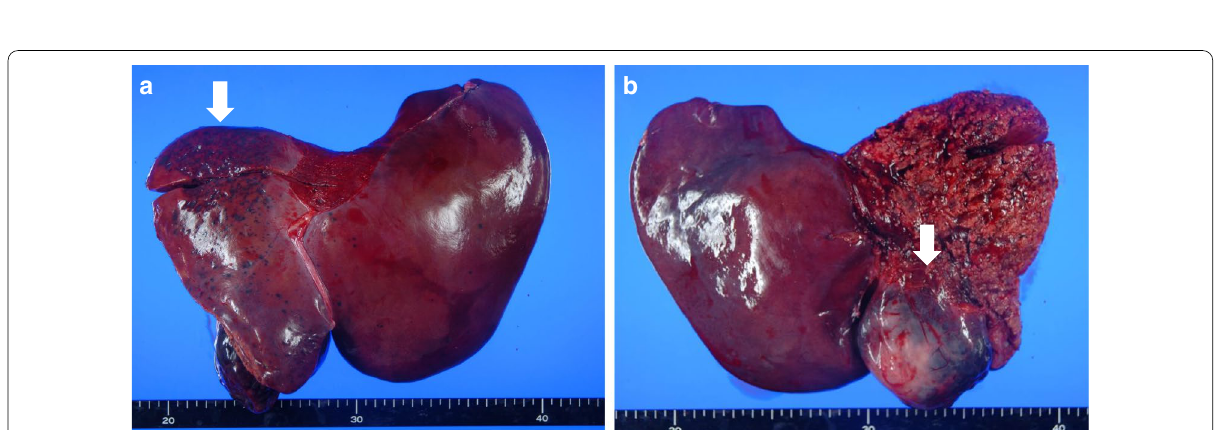
Fig. 4 Resected specimen of left lobe of the liver. a Multiple lesions with small areas of small red patches (white arrow). b A well-defined lesion containing a 6.5-cm-sized blood clot (white